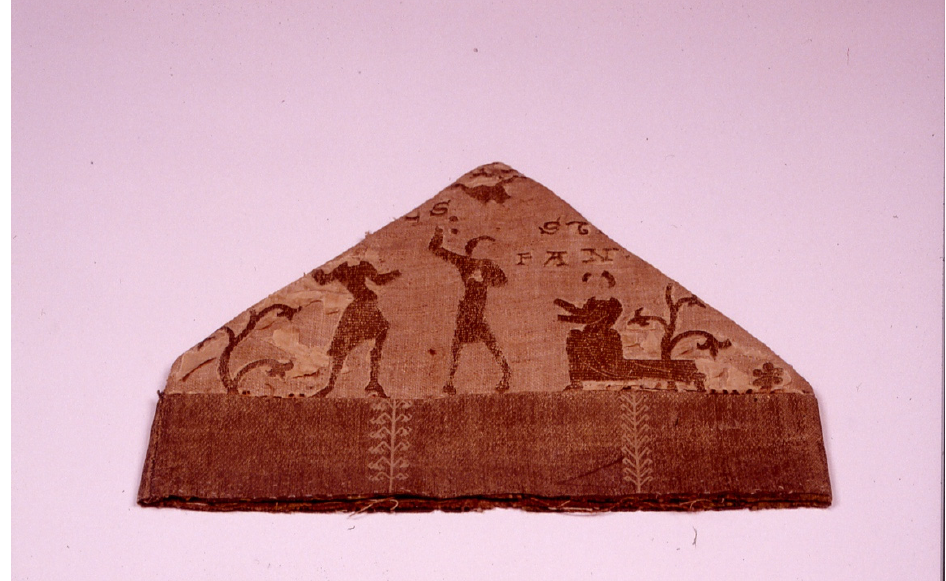
Figure 6. Sens Mitre, rear face with the Stoning of St Stephen. Musées de Sens, France. © Musées de Sens—E. Berry.